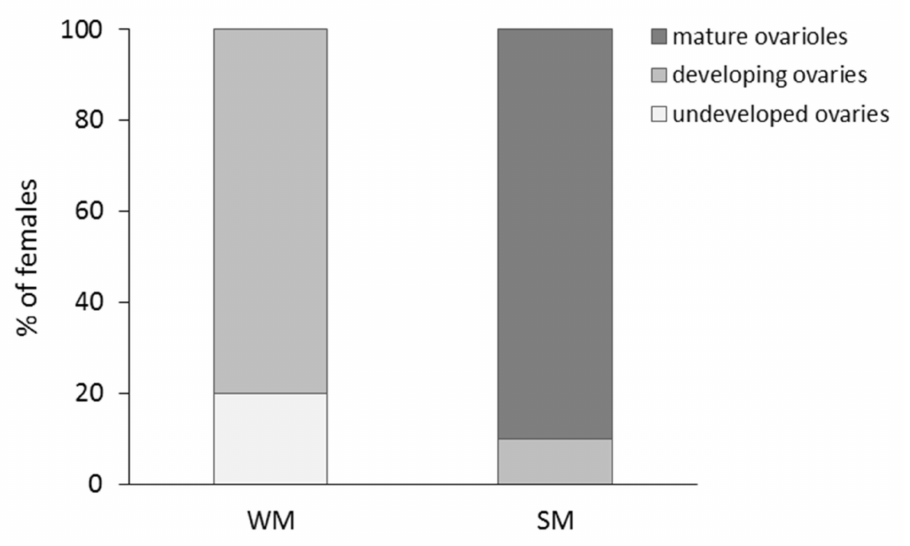
Figure 5. Percentage of WM and SM females with different levels of reproductive maturity. Drosophila suzukii females were dissected 72 h after eclosion, and before all individuals were subjected to the field conditions of the coastal (mild winter) and the mainland (cold winter) area.